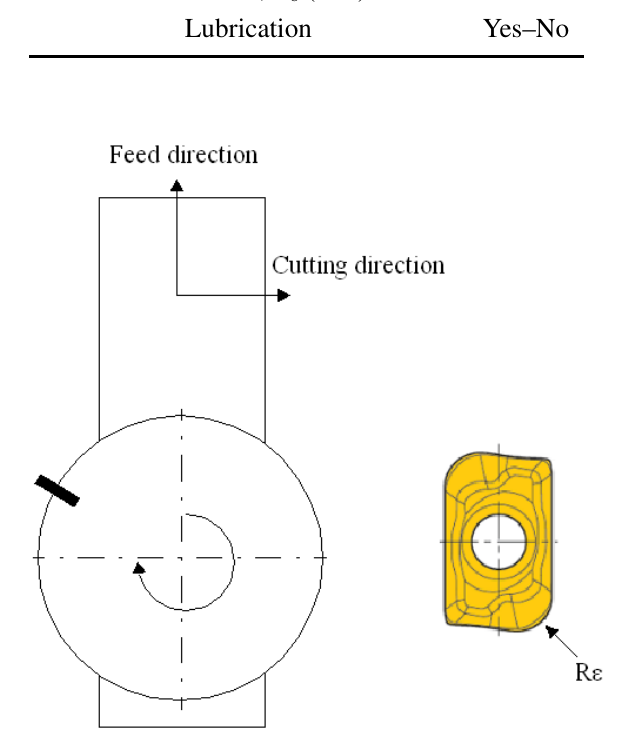
Figure 2. Schematic of face milling and